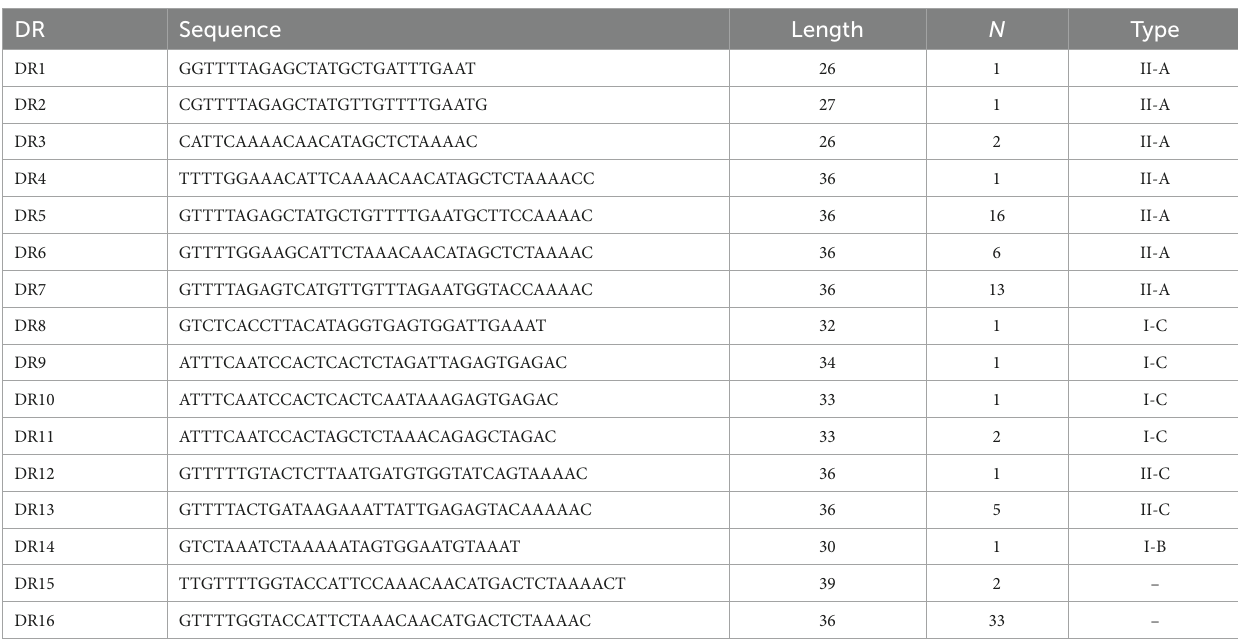
TABLE 2 16 groups repeat sequences of Enterococcus CRISPR